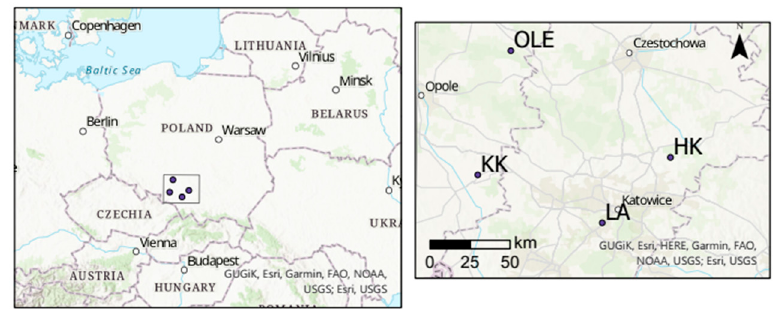
Figure 12. Sampling sites-forests closed to D ą browa Górnicza (HK: 50°24 ′ N 19°28 ′ E); K ę dzierzyn- Ko ź le (KK: 50°20 ′ N 18°19 ′ E), Ł aziska (LA: 50°8 ′ N; 18°53 ′ E) and a reference site